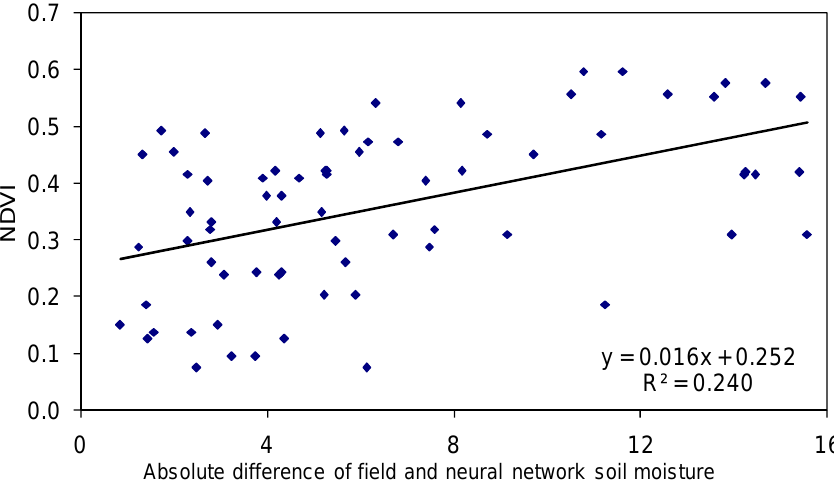
Figure 7. Plot showing difference of neural network based with field measured soil moisture is increase with Normalized Difference Vegetation Index.